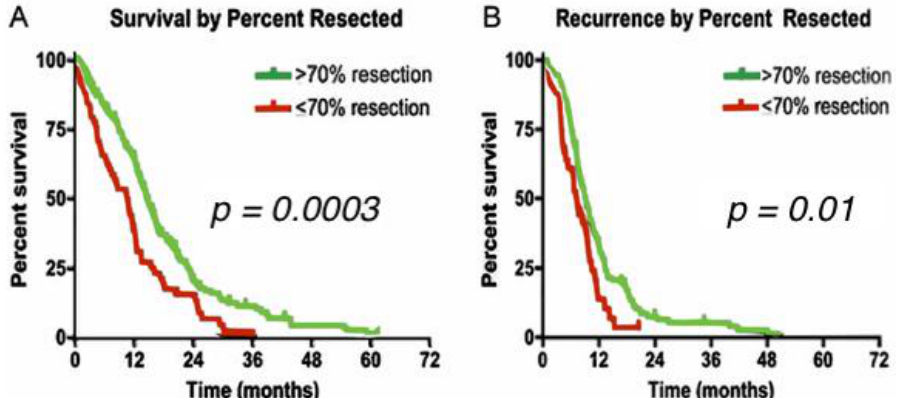
Figure 1. Kaplan Meyer curves of extent of resection in high grade gliomas (HGG). ( A ) The median survival for patients with >70% tumor resection was 14.4 months compared with 10.5 months for patients with ≤70% resection ( p = 0.0003); ( B ) The median percent free survival for patients with >70% tumor resection was 9.0 months compared with 7.1 months for patients with ≤70% resection ( p = 0.01). (Reproduced from Chaichana et al. [7]).